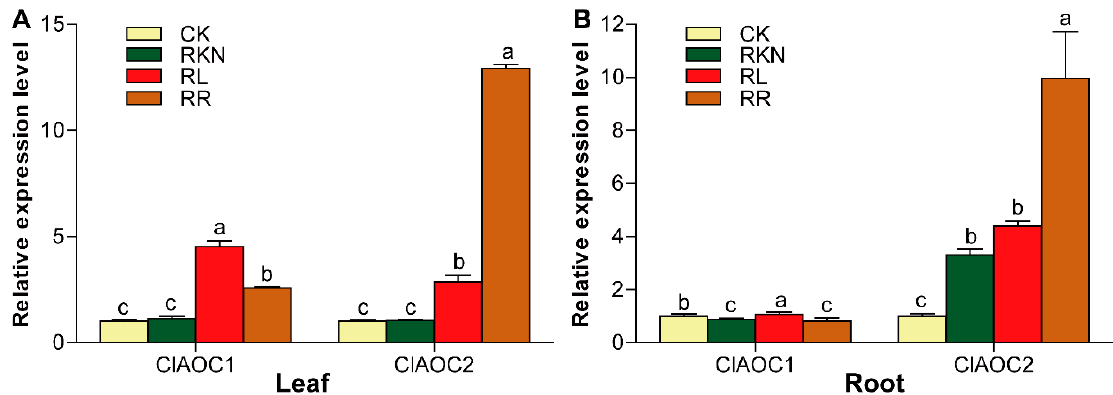
Figure 8. qRT-PCR analysis of expression of ClAOC1 and ClAOC2 in leaves ( A ) and roots ( B ) of inoculation with nematode under the treatments of white light (RKN), red light and water control (RL), nematode under red light (RR) and white light and clean water (CK).